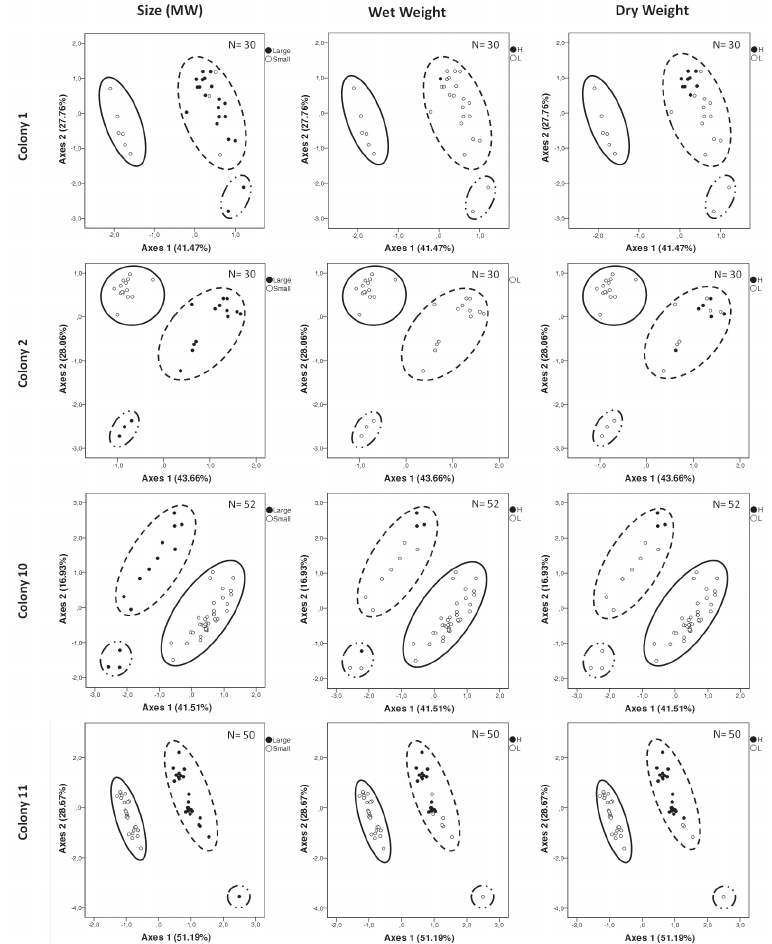
Figure 3. PCA of the three CHC profiles labelled by hornet size, WW and DW. Principal Component Analysis of CHC profiles in each of the four autumn colonies. Chemical groups are defined by continuous line: Group 1; dash line: Group 2 and dot-dash line: Group 3. PCA dots show representations according to GMMs size, wet weight and dry weight thresholds of hornets. Size, Black dots: Large females (MW ≥ 4.5 mm); White dots: Small females (MW < 4.5 mm). Wet weight, Black dots: Heavy fresh females (≥ 0.618 g); White dots: Light fresh females (< 0.618 g). Dry weight, Black dots: Heavy dry females (≥ 0.225 g); White dots: Light dry females (< 0.225